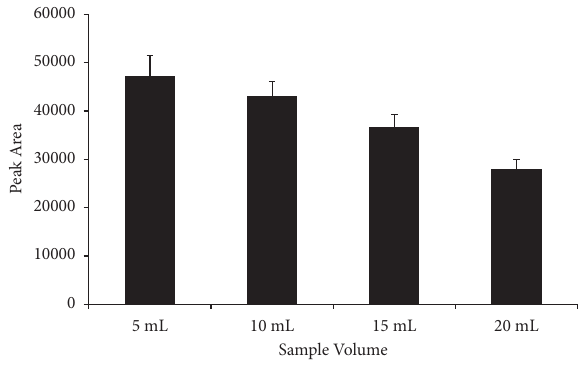
Figure 7: Effect of sample volume on extraction efficiency. Ex- traction conditions: extraction time 20min and desorption time 30min with 0.01M sulfuric acid as the desorption solvent; no adjustment of sample